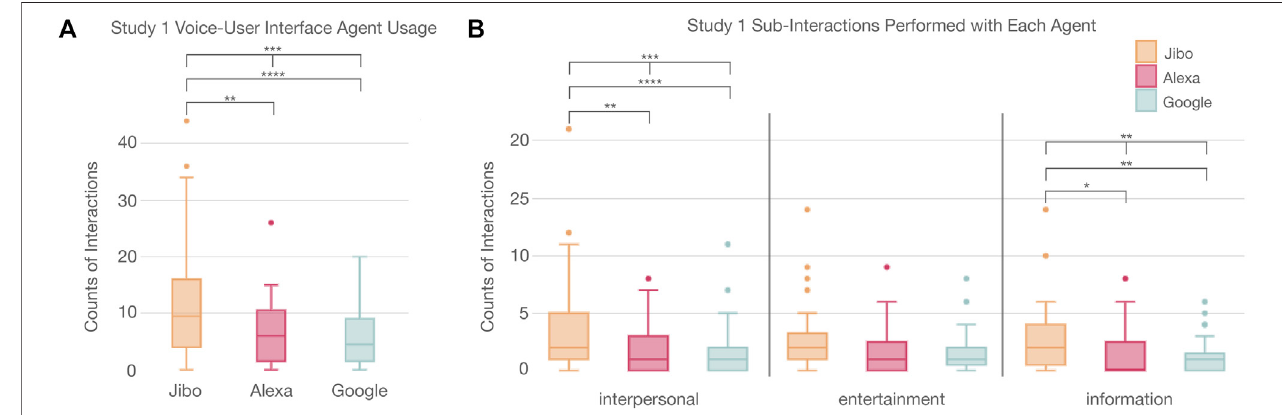
FIGURE4|(A) Signi fi canttrendinusageofvoiceagentsbetweenparticipantsshowingJibohadasigni fi canthigherusagethanAlexaorGoogle. (B) Distributionof the interactions completed with various agents showing that participants engaged with agents differently for interpersonal and information based